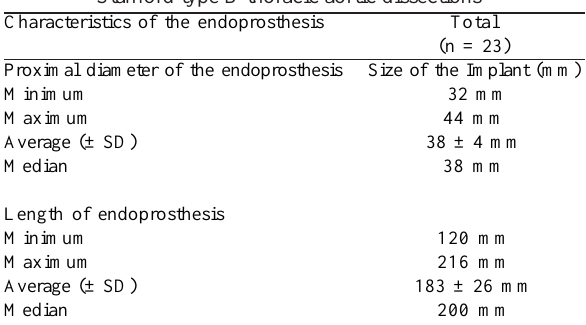
Table 5. Type of endoprosthesis implanted in the 23 patients submitted to endovascular treatment of